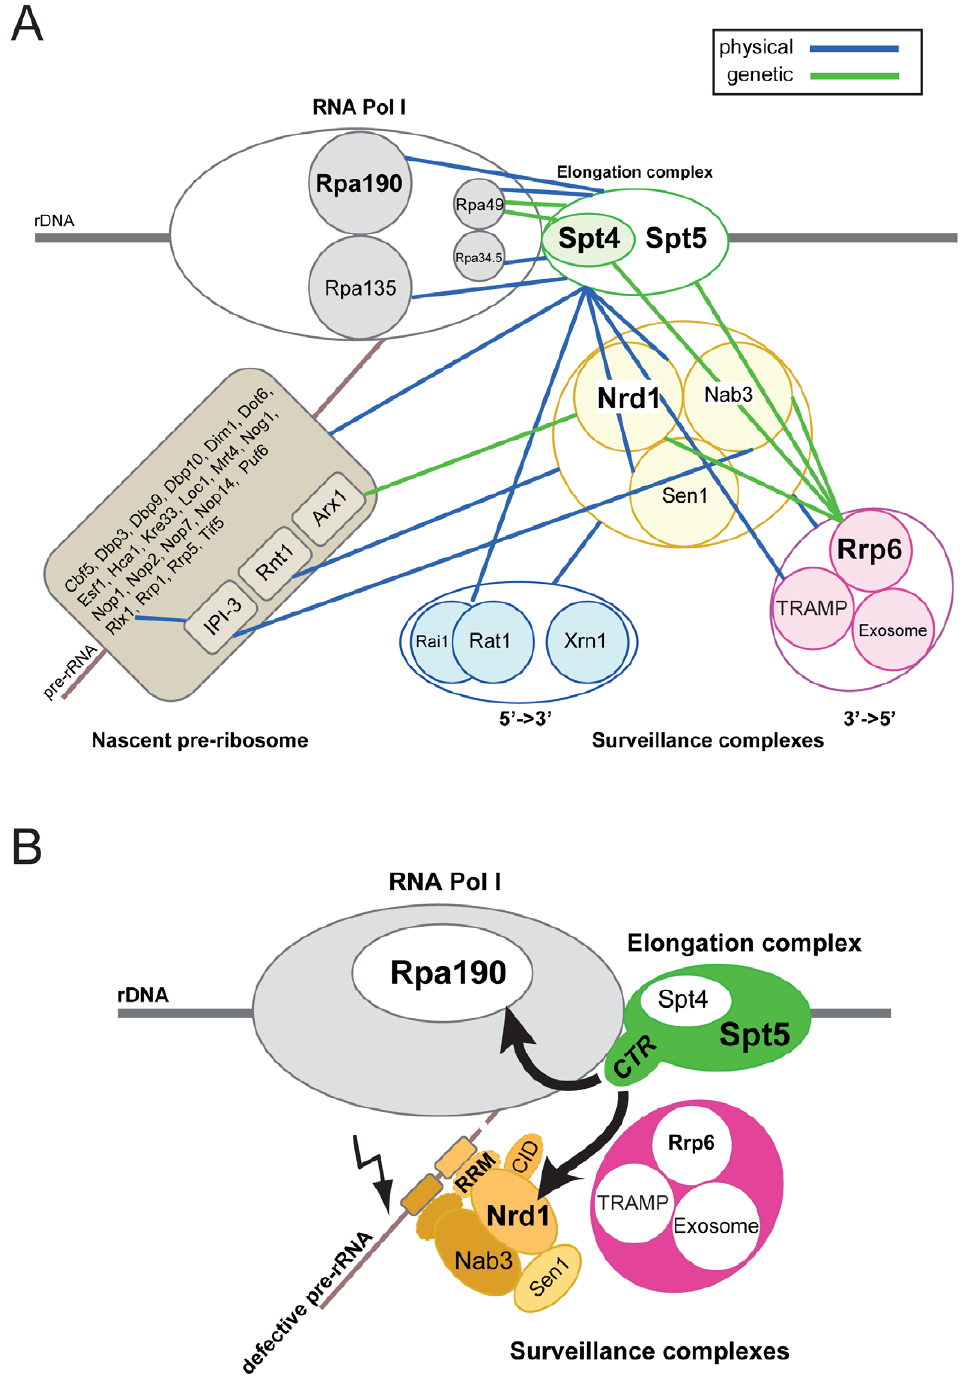
Figure 6. A physico-functional interface at the rDNA that connects rRNA synthesis, rRNA processing, and rRNA surveillance. A, The RNA Pol I, the Spt4–Spt5 elongation complex, the Nrd1-Nab3-Sen1, and the RNA exosome interact physically and are poised to interact functionally. We suggest that the Nrd1-Nab3-Sen1 complex contributes to recruiting 3 9 -to-5 9 nucleolar surveillance to nascent pre-rRNA transcripts. Interactomics suggest that 5 9 -3 9 nucleolar surveillance might also be recruited, but this has not addressed in this work. Rpa135-Rpa190, catalytic core of RNA Pol I; Rpa34.5-Rpa49, intrinsic elongation factor. Color-code: blue (physical interaction, affinity purification and in vitro pull-down), green (genetic interaction, limited to synthetic growth defect). Interaction dataset curated from BioGrid and from this work. B, Model for early recognition of defective pre-ribosomes: in conditions in which ribosome assembly is compromised (delayed assembly of ribosome synthesis factors or ribosomal proteins and/or misfolded RNA, lightning symbol), we speculate that cryptic Nrd1-Nab3 binding sites become available for binding. We suggest that the elongation factor Spt4–Spt5 recruits and deposits the Nrd1-Nab3 complex, which in turn attracts the RNA exosome to defective pre-rRNA transcripts.